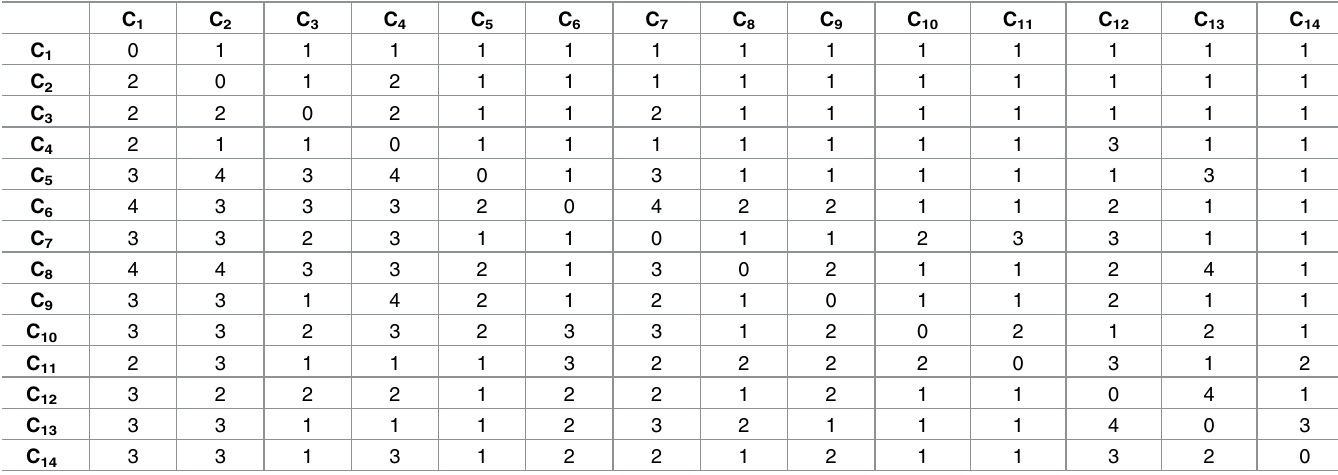
Table 3. The averageddirect-relation matrix for criteria.